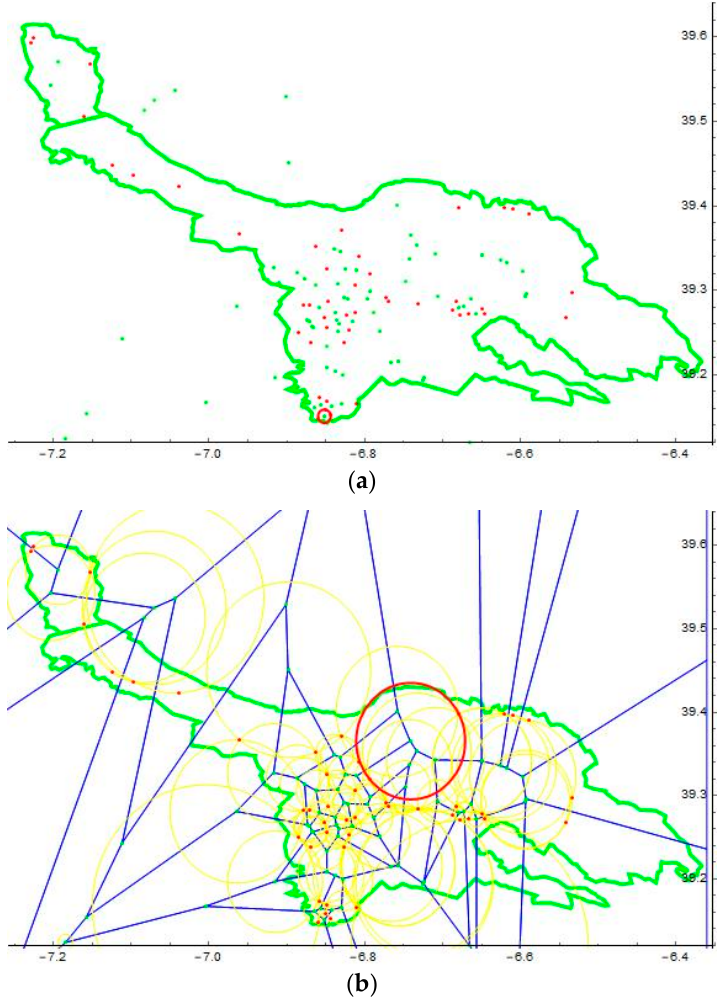
Figure 2. Location of the region with the greatest risk of infection (( a ) focus 6) and the least one (( b ) focus 43).